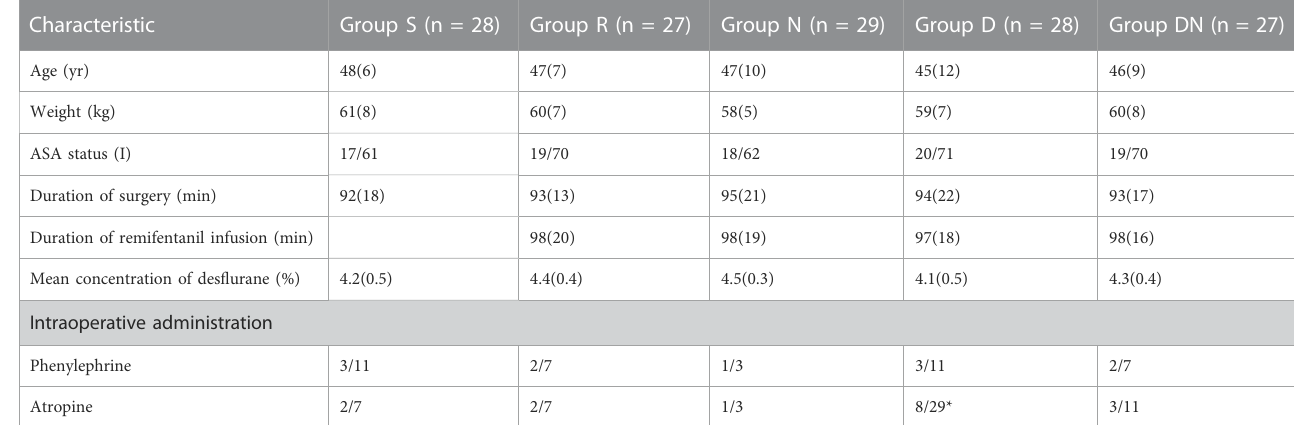
TABLE 1 Patient characteristics and anesthetic data. Group S: Intraoperative sufentanil 0.20 μ g kg − 1 and pre-anesthesia saline; Group R: Intraoperative remifentanil 0.20 μ g kg − 1 min − 1 and pre-anesthesia saline; Group N: Intraoperative remifentanil 0.20 μ g kg − 1 min − 1 and pre-anesthesia nalmefene 0.20 μ g kg − 1 ; Group D: Intraoperative remifentanil 0.20 μ g kg − 1 min − 1 andpre-anesthesia dexmedetomidine 0.50 μ g kg − 1 ;Group DN:Intraoperative remifentanil 0.20 μ g kg − 1 min − 1 andpre- anesthesia nalmefene 0.10 μ g kg − 1 combined with dexmedetomidine 0.25 μ g kg − 1 . All patients underwent laparoscopic gynecological surgery under des fl urane anesthesia. Values are presented as the mean (SD), or the number of patients/%. * p < 0.05 vs. group R, ** p < 0.01 vs. group R. ASA: American Society of